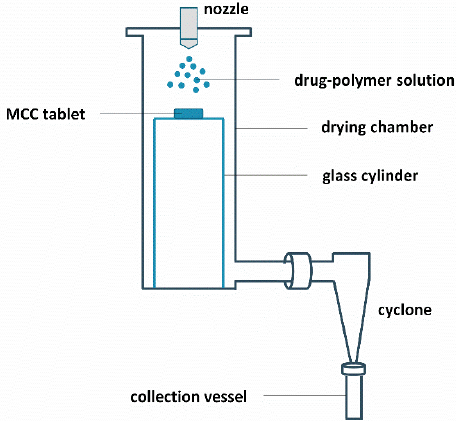
Figure 4. Schematic illustration of the surface coating setup.